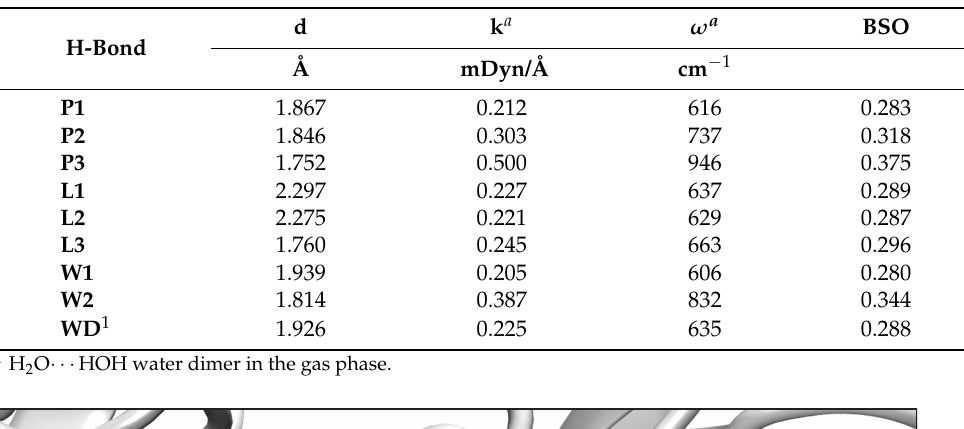
Table 7. The local mode parameters of the hydrogen bonds between Quercetin and NS5 from the QM/MM calculations, ω B97X-D/6-31G(d,p)/AMBER level of theory for the calculation in the protein, and ω B97X-D/6-31G(d,p) level of theory in the gas phase.